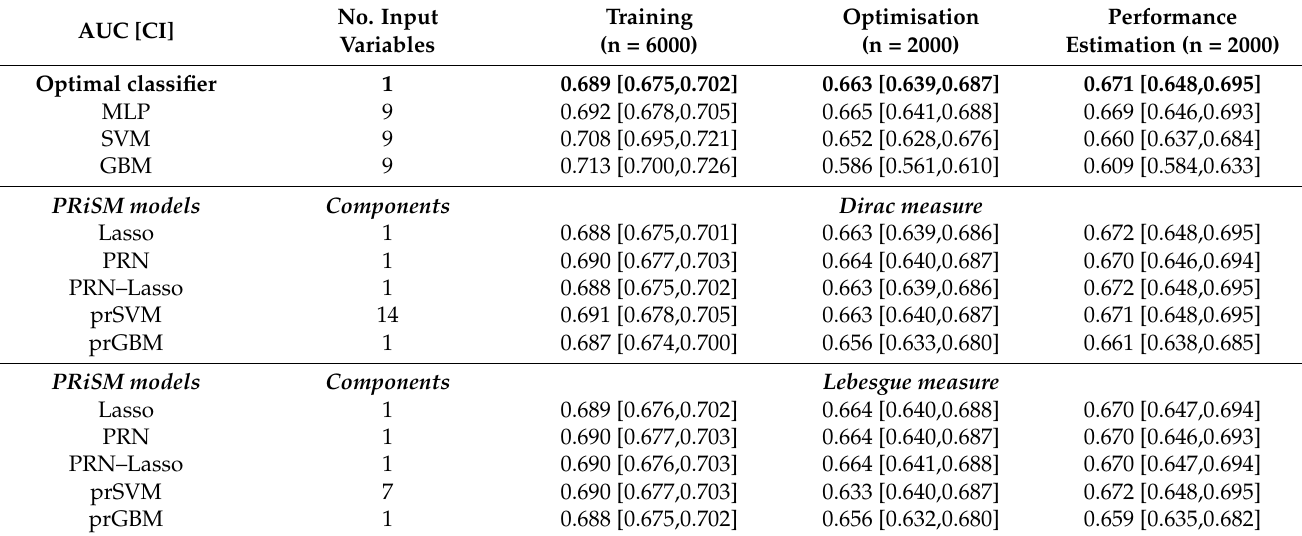
Table 2. Classification performance for the XOR function measured by the AUC [CI]. The input variables x 3 and x 4 are ideally selected solely for their bivariate response.